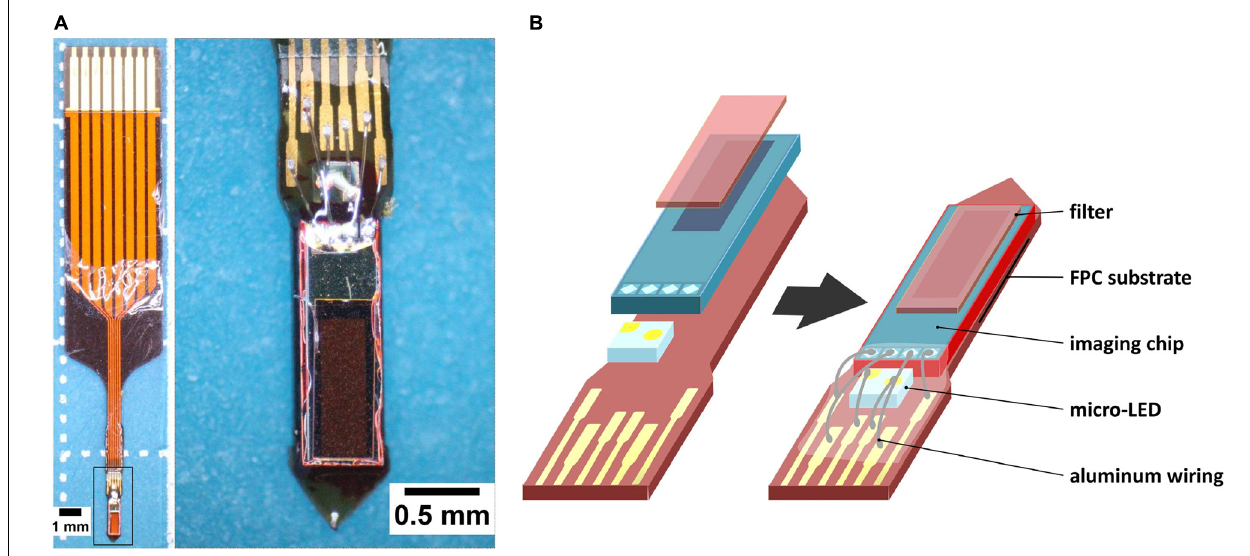
FIGURE 1 | CMOS-based implantable needle-type device for fluorescence imaging. (A) Left: Image of the needle-type implantable device as seen under a microscope (28 × magnification). This device has undergone all steps of the fabrication process; Right: Higher magnification of the imaging device (from selection, 45 × ). (B) Partial breakdown of the device (left), and the placement of its components (right).